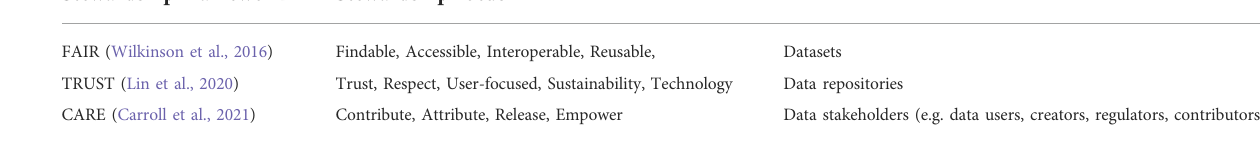
TABLE 1 Data stewardship frameworks.